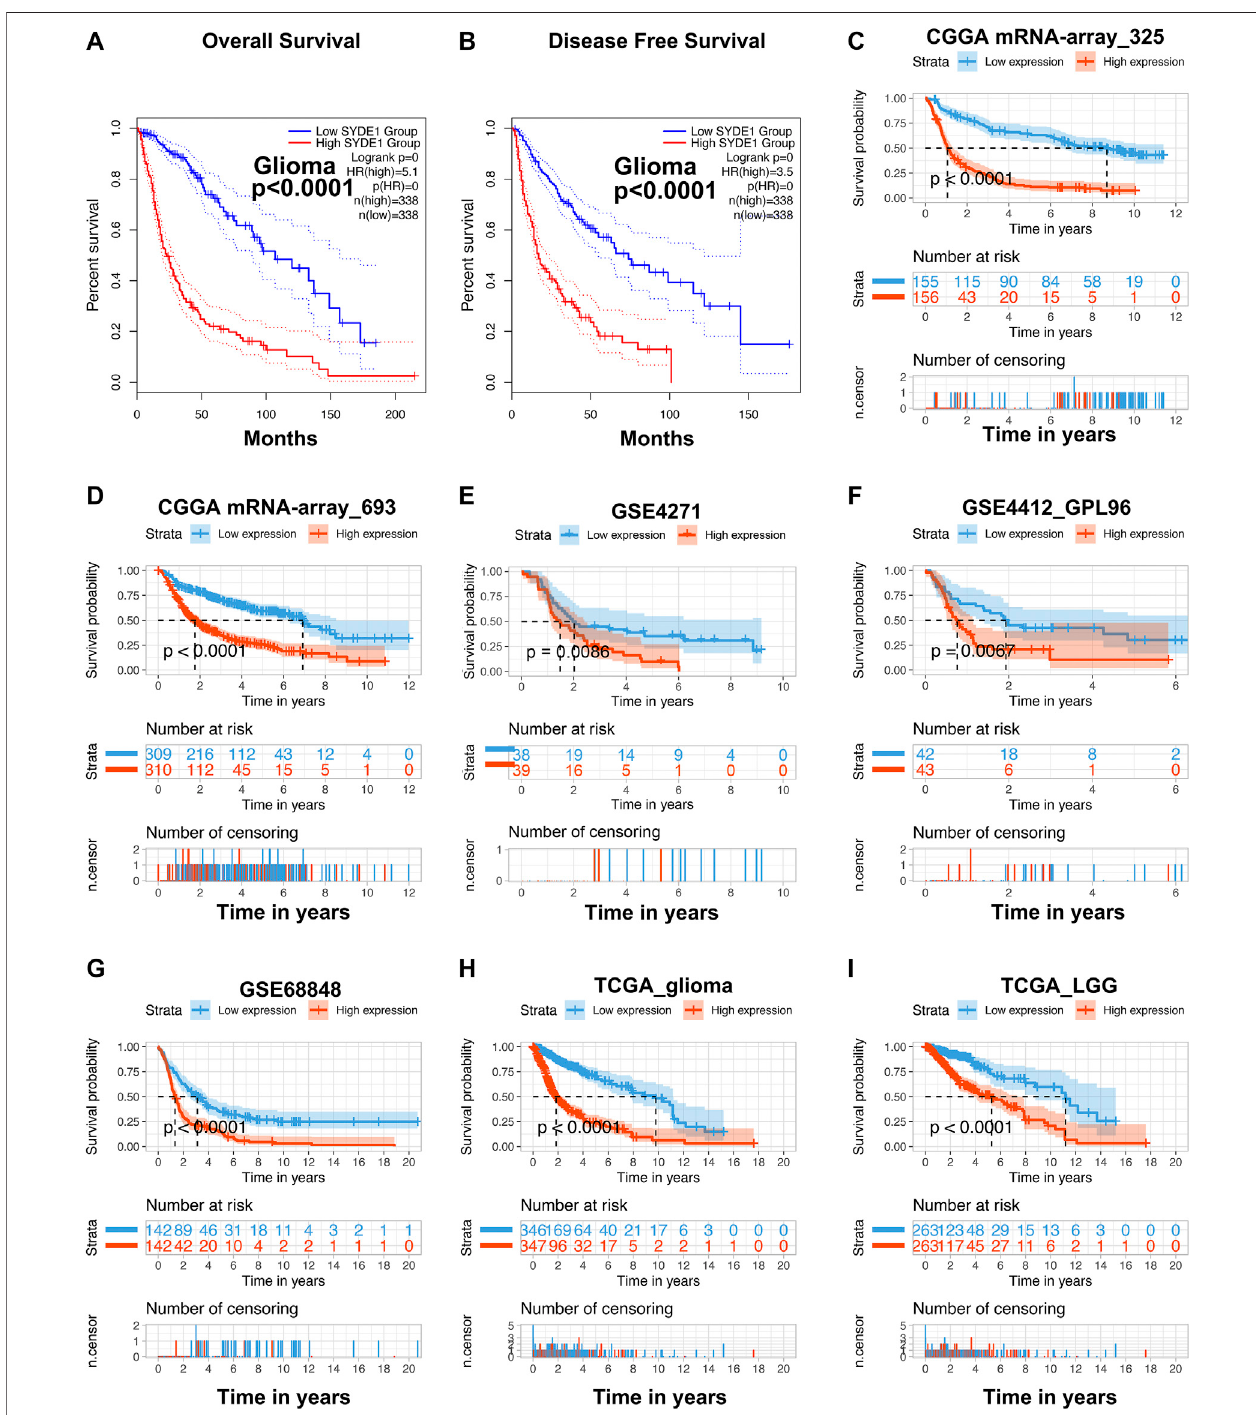
FIGURE 7 | Evaluation of the prognostic value of SYDE1 in different datasets. (A – B) Patients with low SYDE1 expression groups had a long median OS and DFS thanhigh SYDE1 expression groups,respectively(GEPIA2). (C – I) Thehighexpressionof SYDE1 waspositivelyrelated toinferiorprognosisregardingOSbydatamining in different datasets, including mRNA-array_325, mRNA-array_693 of CGGA, GSE4271, GSE4412_GPL96, GSE68848, TCGA_glioma, and TCGA_LGG, respectively.